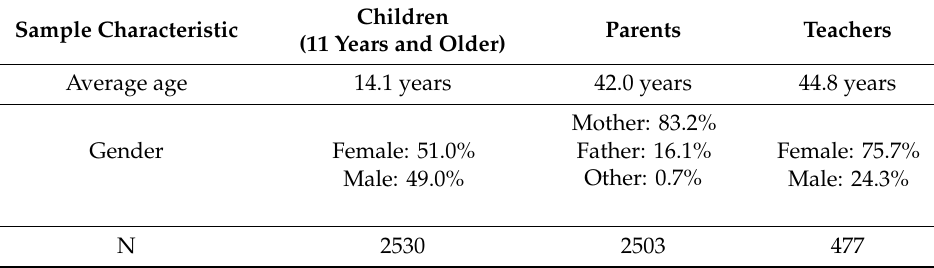
Table 3. Sample characteristics (children, parents and teachers, T1 measurement,